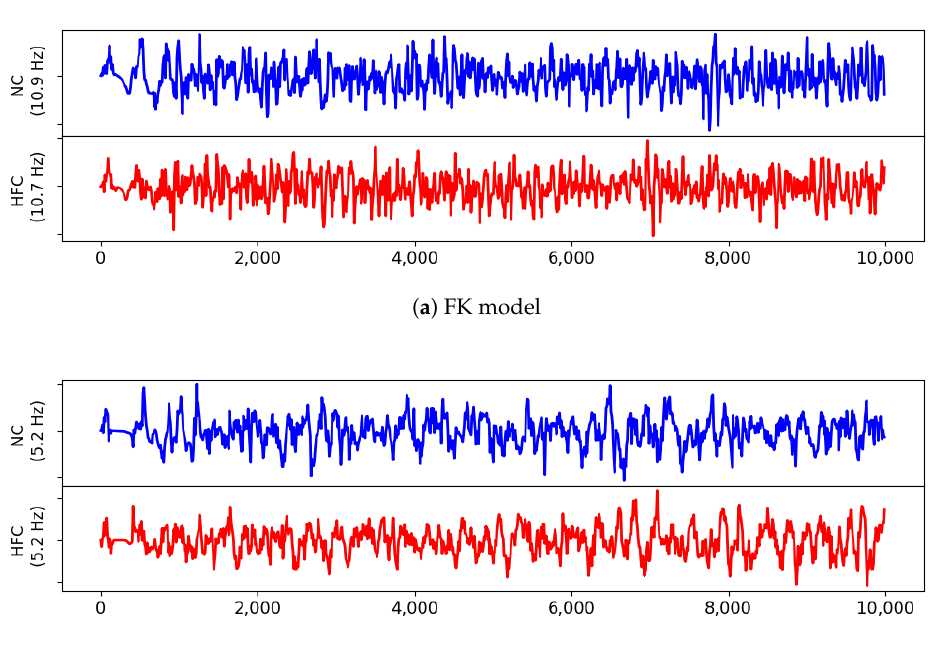
Figure 7. Pseudo-ECG computation for the ( a ) FK model and ( b ) the TP06 model. The fundamental frequency is also shown for each case